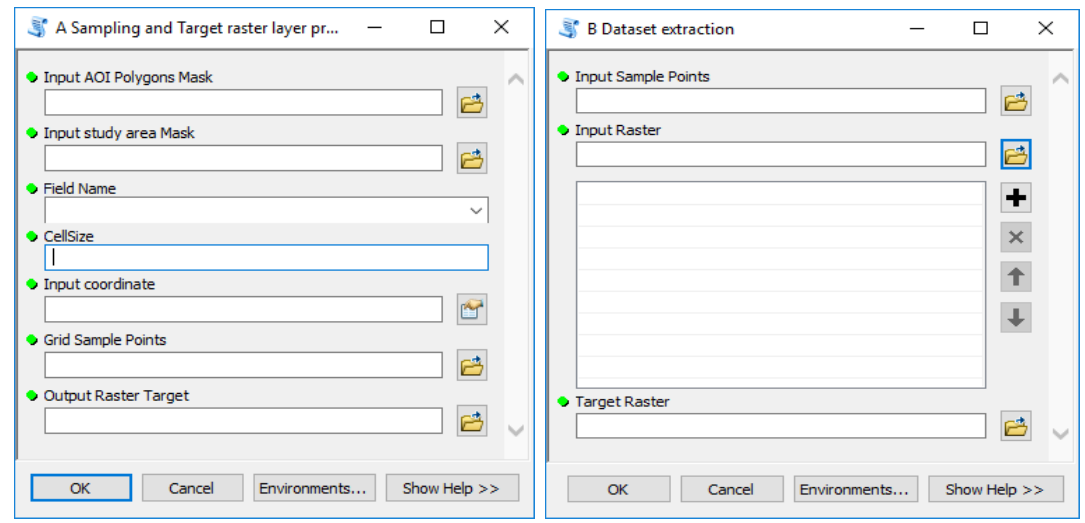
Figure 2 Tool Parameterization (A) Sampling and Target raster layer process. (B) Dataset extraction.